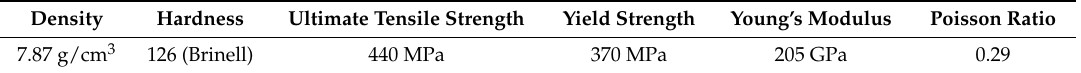
Table 2. Mechanical properties of the AISI 1018 mild steel.